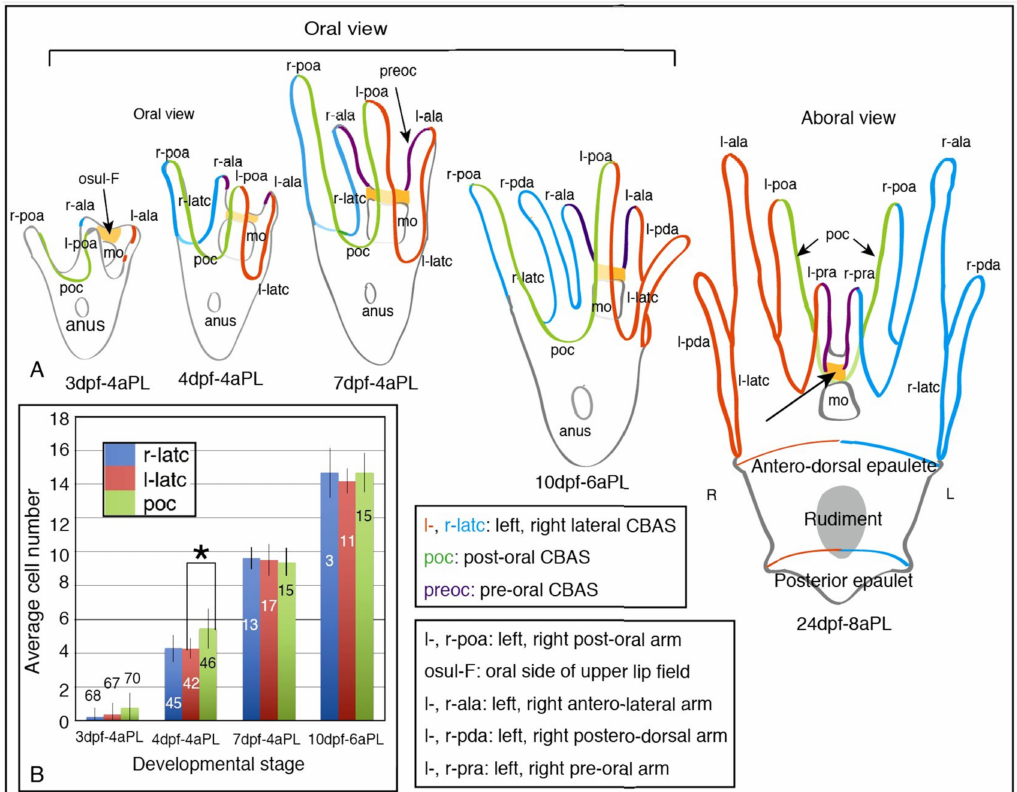
Figure 3. Schematic summary of the CBAS pattern formation. ( A ) Schematic process of the CBAS pattern formation from the 3 days post-fertilization, 4-arm pluteus stage (3dpf-4aPL) to 24dpf-8aPL, immediately before metamorphosis. The long arrow on 24dpf 8aPL: suspended CBAS near the apical ganglion. ( B ) Increasing cell number of the CBAS from 3dpf-4aPL to 10dpf-6aPL, with error bars. Asterisk: the number of post-oral CBAS (poc)-constituting cells is statistically significantly larger than that of r- and l-latc. p = 0.0001 < 0.05. The number on each column is the total number of larvae subjected to count the cell number in the